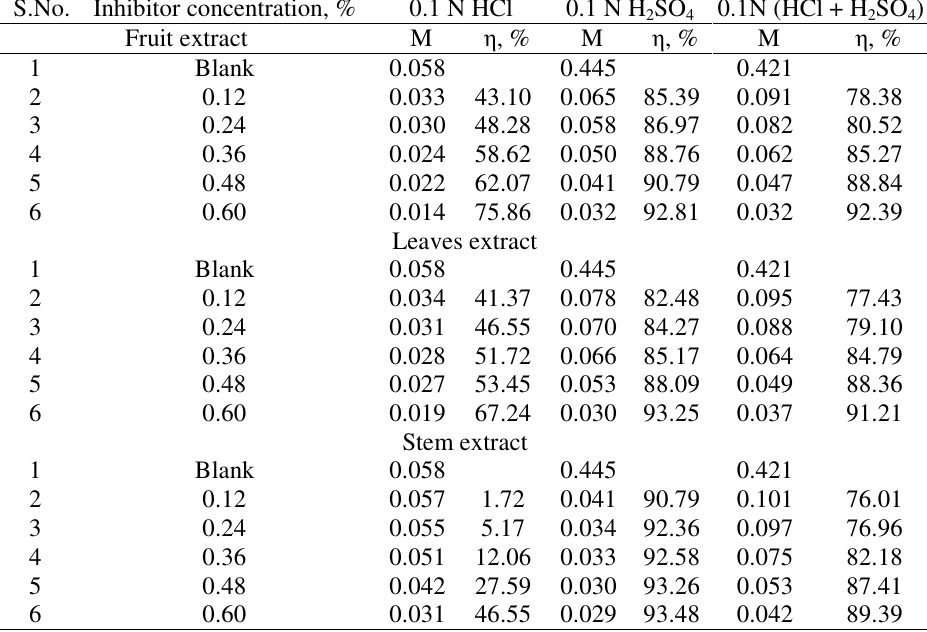
Table 1. Mass loss and inhibition efficiency for mild steel in different acid solution with alcoholic extracts of plant Cordia dichotoma at 299±0.2 K (Area of exposure - 7.75 cm 2 Time of exposure - 18